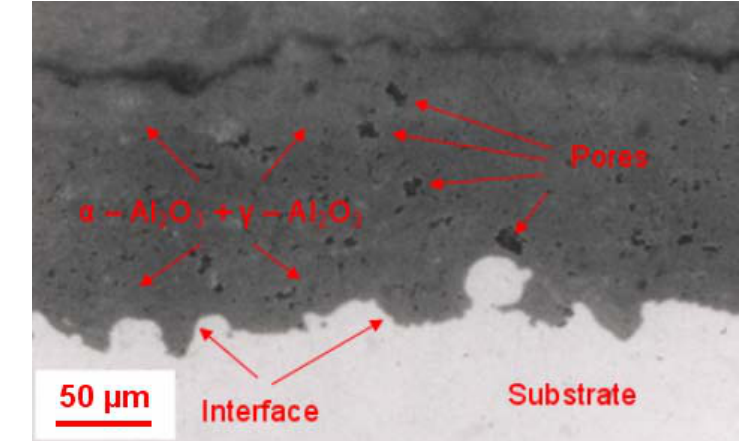
Рис . 5 – Поперечное сечение и микроструктура Al 2 O 3 покрытия (800A) Слика 5 – Попречни пресек и микроструктура Al 2 O 3 превлаке (800